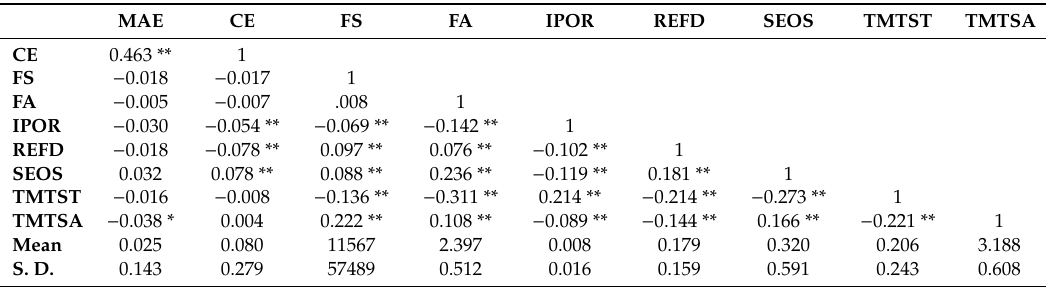
Table 3. Means, standard deviations, and correlations (N =